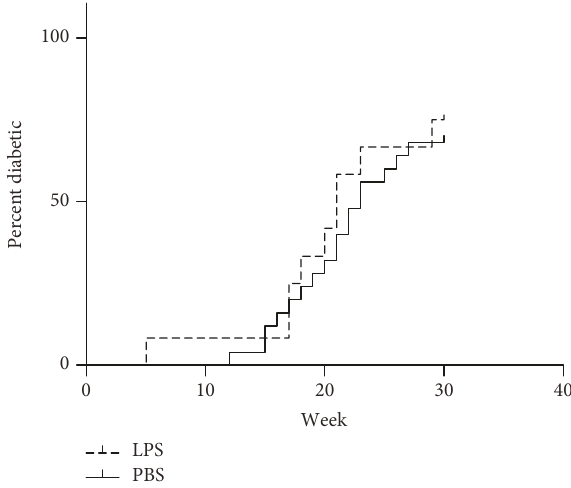
Figure 3: Incidence of type 1 diabetes diagnosed as three consecutive blood values of glucose > 12mmol/l in NOD/MrkTac mice given either LPS ( n = 18 ) or PBS ( n = 22 ) orally daily from birth until weaning at four weeks of age and observed until 30 weeks of